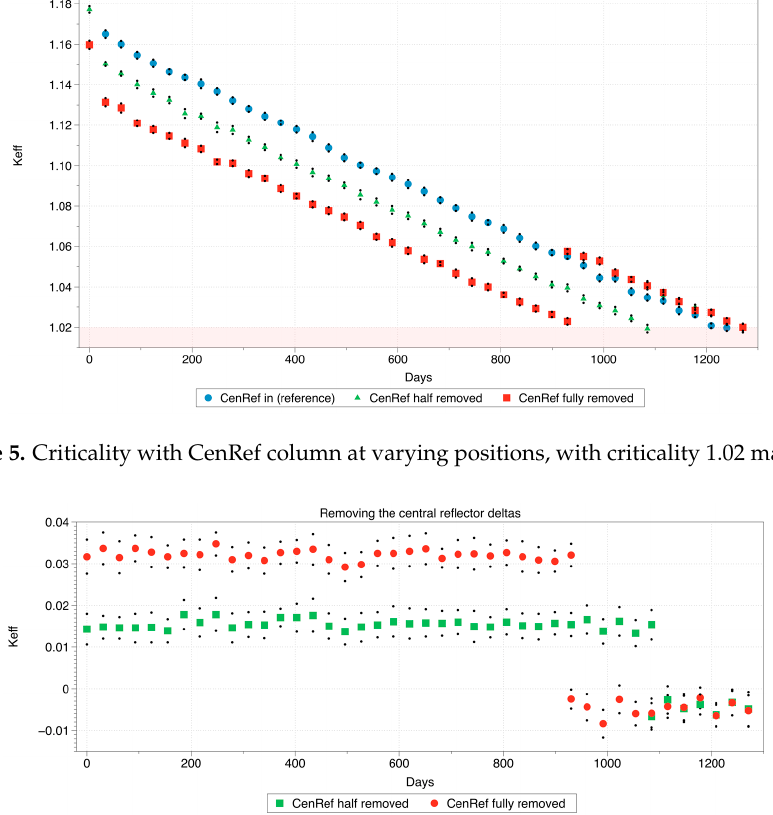
Figure 6. Delta from base of CenRef removal (Reference—Half removed) & (Reference—Fully removed).